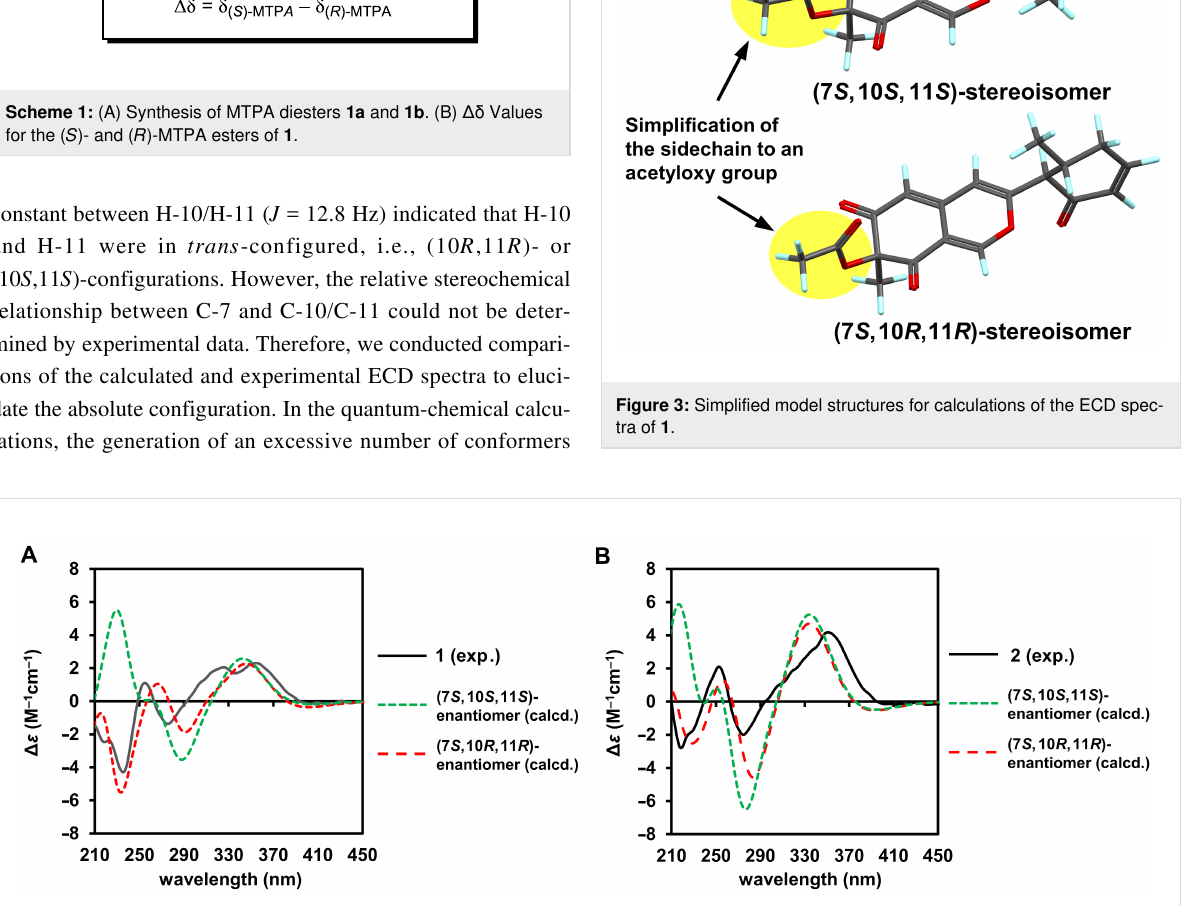
constant between H-10/H-11 ( J = 12.8 Hz) indicated that H-10